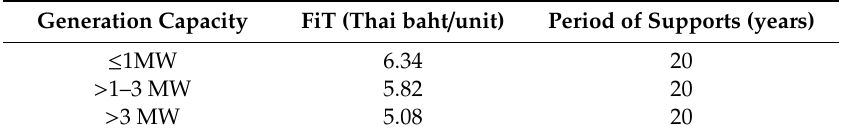
Table 1. Feed-in-tari ff s (FiTs) for electricity generation from municipal solid waste (MSW) in